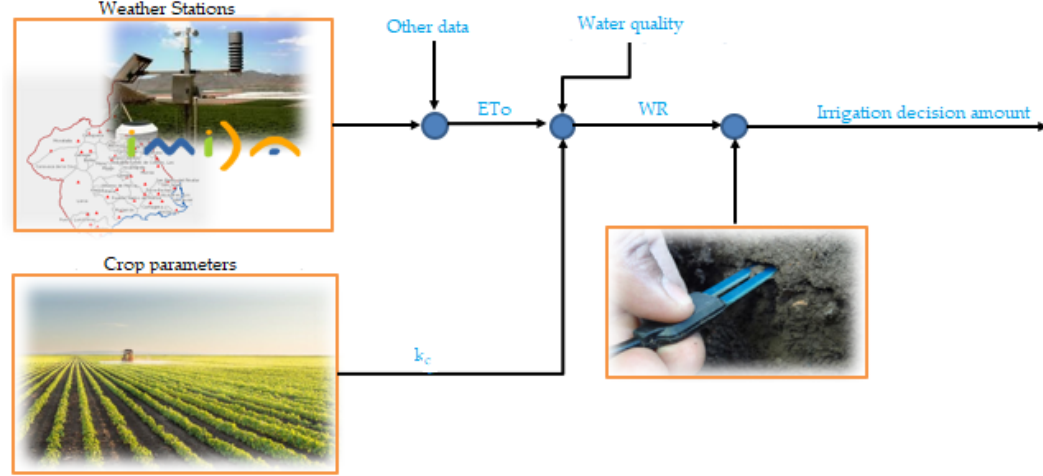
Figure 1. Process used by the agronomist to determine irrigation dose and frequency.